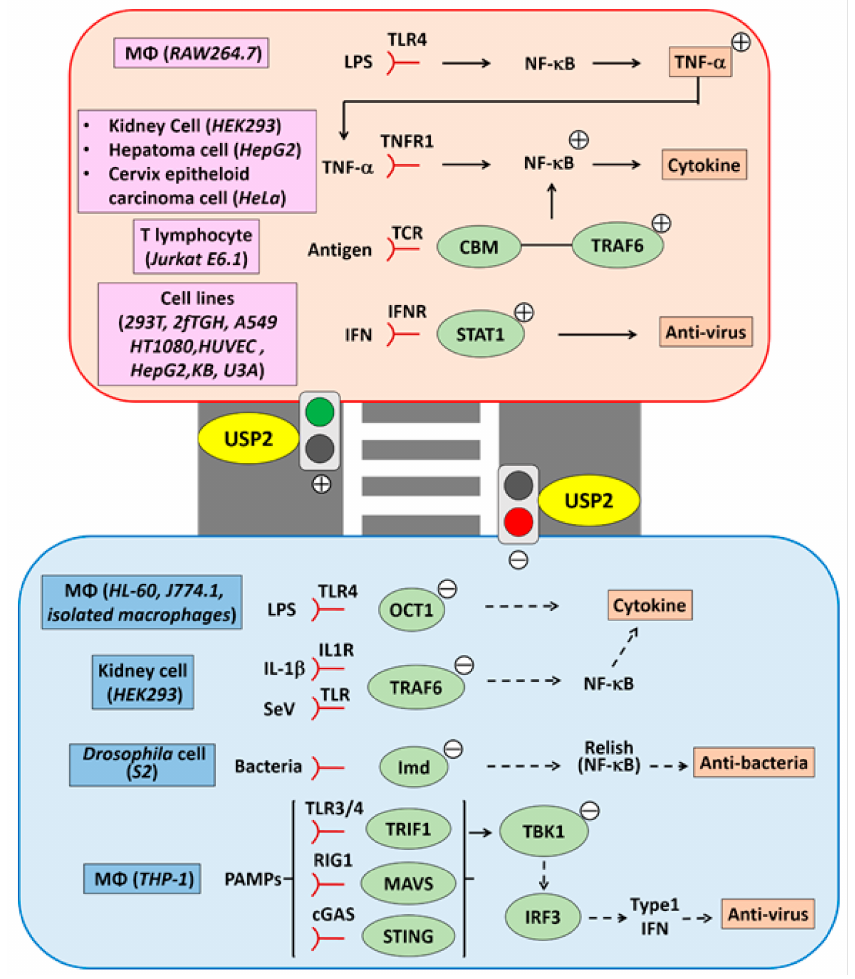
Figure 3. Roles of USP2 in immune and inflammatory responses. Previous reports indicate that USP2 exerts both positive and negative effects on immune and inflammatory responses. USP2 stabilizes TNF- α and the TNF- α –elicited signaling complex, leading to activation of NF- κ B. USP2 also potentiates NF- κ B activation in T-lymphocytes via the interaction between the CBM complex and TRAF6. Moreover, USP2 stimulates nuclear accumulation of STATs, which promotes antiviral activity in cells. In contrast, there are papers demonstrating that USP2 modifies OCT1, TRAF6, and Imd ( Drosophila orthologue of RIP1) to suppress the expression of proinflammatory cytokines and anti-bacterial peptides. Additionally, USP2 modulates TBK1 to attenuate signaling along the RIGI, cGAS/STING, and TRIF pathways. USP2-elicited attenuation of TBK1 also lowered IRF3 activation, resulting in decreased IFN β